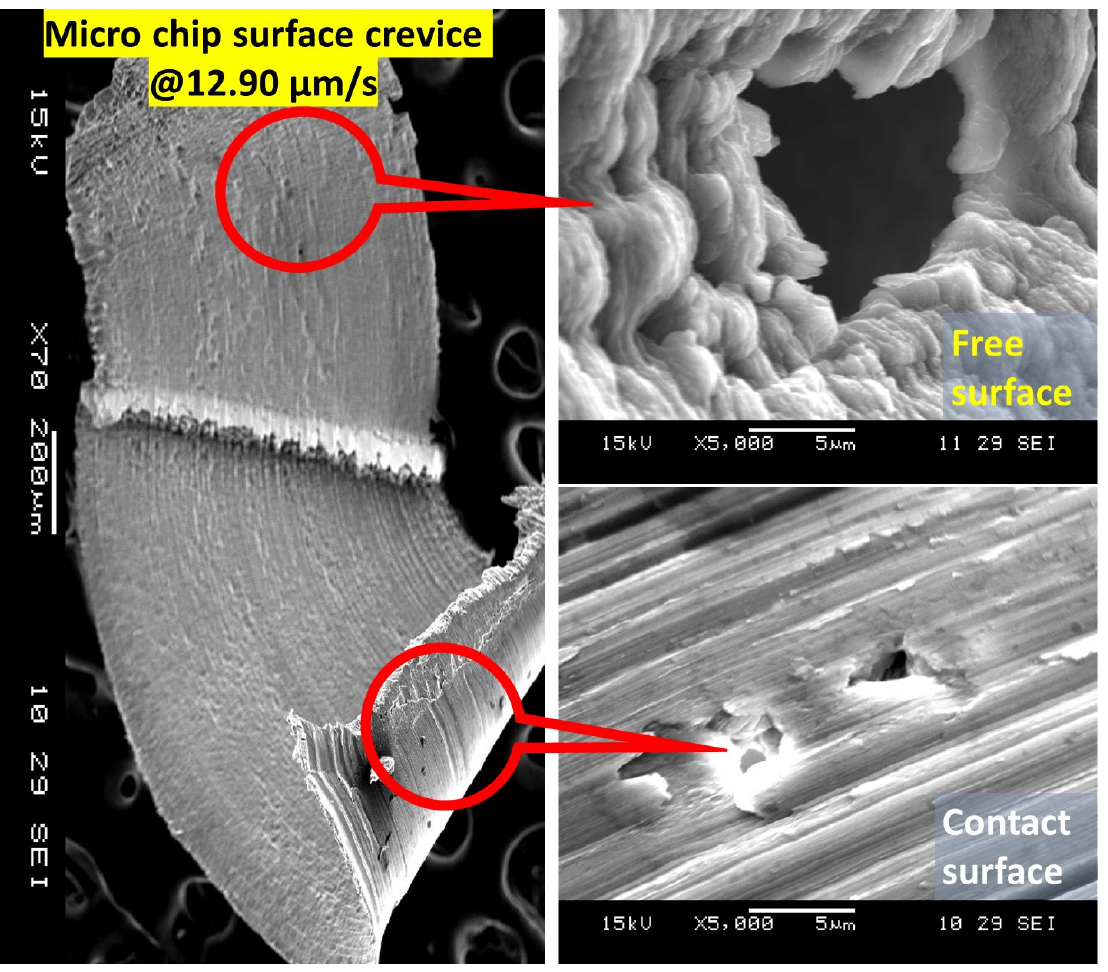
Figure 11. Surface crevice at feed rate 12.90 μ m/s observed in ×5000 magnification SEM image of free and contact surface of Al alloy the microchip.